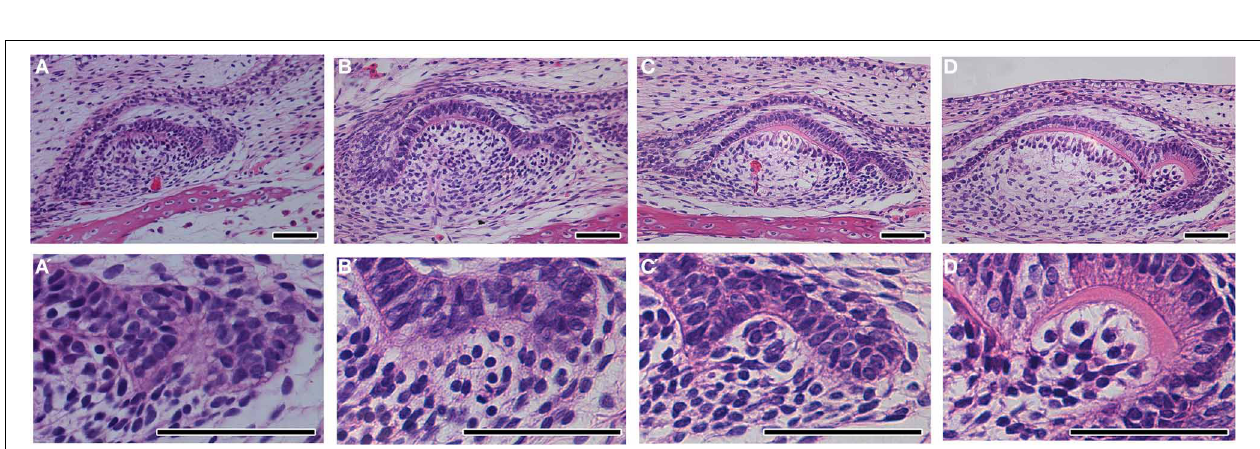
High power views of the images above. The cusps can be seen to form by folding of the inner enamel epithelium. See arrow in (C’) . Scale bar = 100 µ m (A,B) and 50 µ m (C–E, C’–E’) .